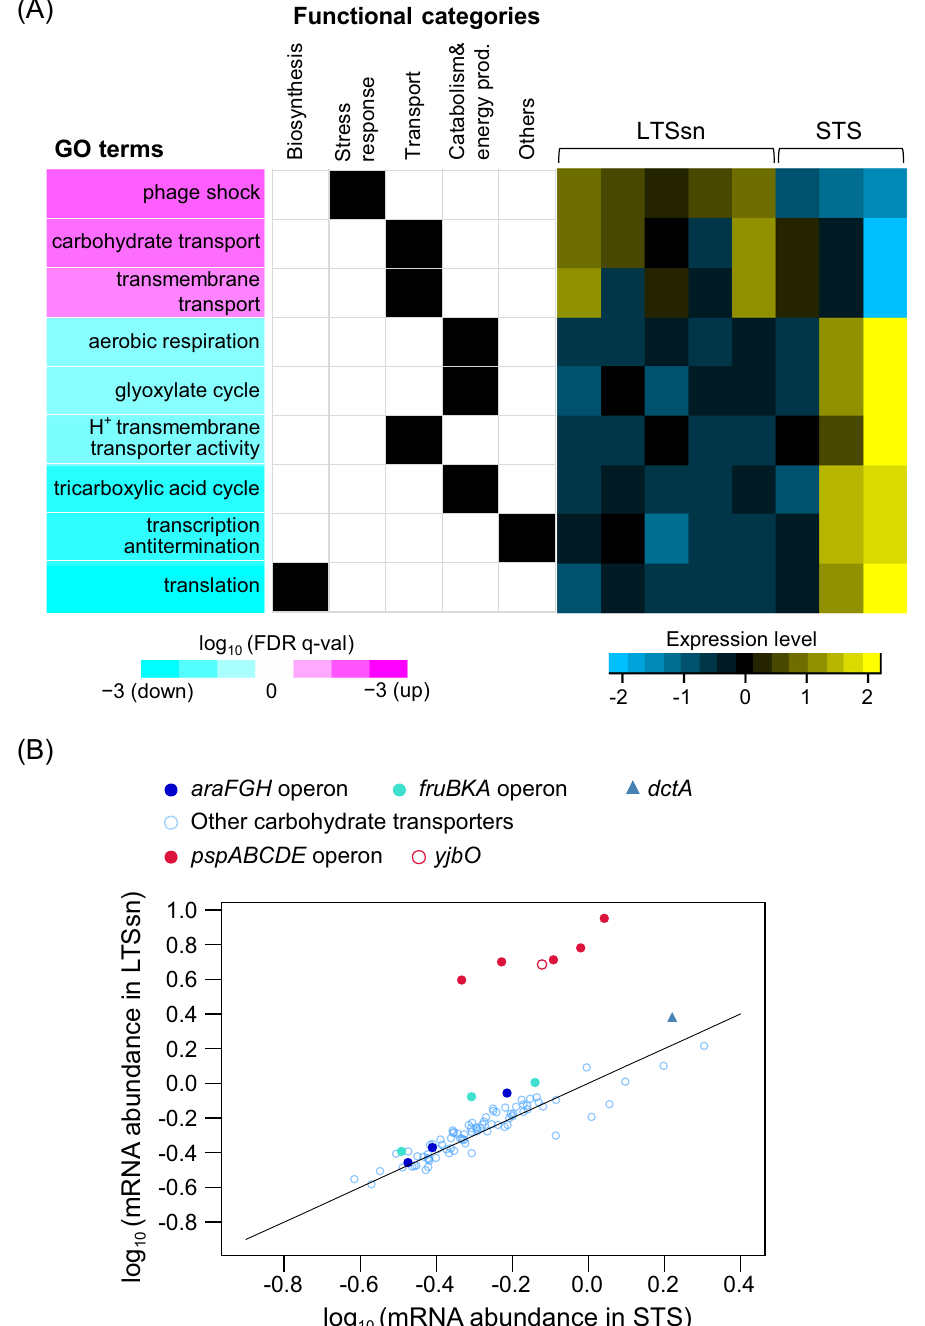
Figure 3. Differentially expressed gene categories in LTSsn compared to STS. ( A ) Representative differentially expressed gene categories extracted by GSEA (False Discovery Rate (FDR), q-value < 0.05). Statistical significance levels (FDR, q-value) are shown as heatmaps. Magenta and cyan in the heat map mean that the expression level of each gene set is higher or lower in LTSsn than in STS, respectively. These screened gene sets were further grouped into five large categories: (1) biosynthesis (child classes or parts of “biosynthetic process (GO:0009058)”), (2) stress response (child classes or parts of “response to stress (GO:0006950)” and “anti-oxidant activity (GO:0016209)”), (3) transport (child classes and parts of “transport (GO:0006810)” or “transporter activity (GO:0005215)”), (4) catabolism and energy production (child classes and parts of “generation of precursor metabolites and energy” (GO:0006091) or “cellular catabolic process” (GO:0044248)), and (5) other categories. If each GO term was grouped into an indicated functional category, the box was filled with black. A yellow-blue scaled heatmap shows the expression levels in each GO term (i.e., the average gene expression levels of all members in each GO term) in biological replicates (LTSsn: n = 5; STS: n = 3). The values of mRNA signals in each extracted GO category were normalized so that the average and the standard deviation in all replicates are 0 and 1. ( B ) Scatter plots of log10 scaled gene expression levels in “phage shock (GO:0009271)” (red circles) and “carbohydrate transport (GO:0008643)” (blue or cyan circles or triangles) in STS or